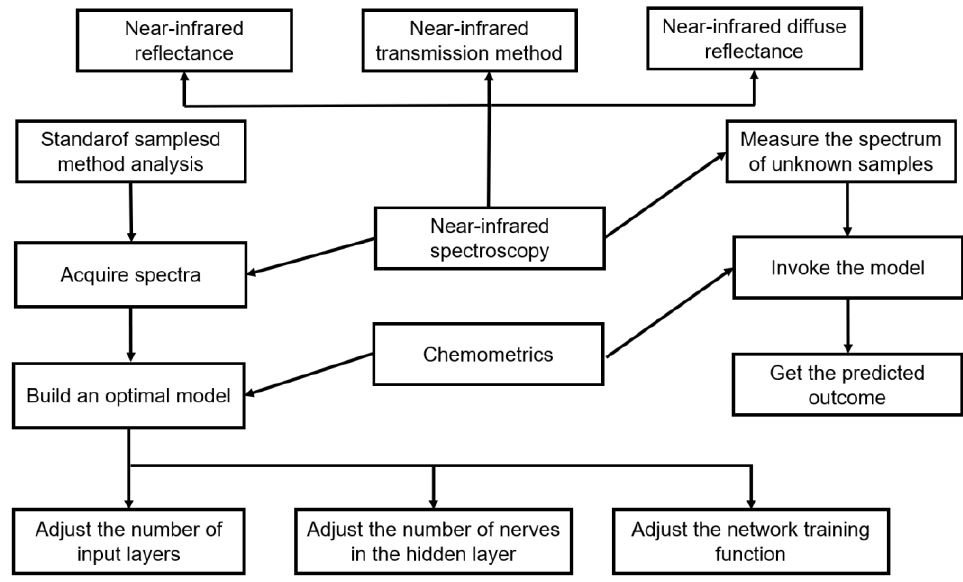
Figure 8. INIS architecture diagram.